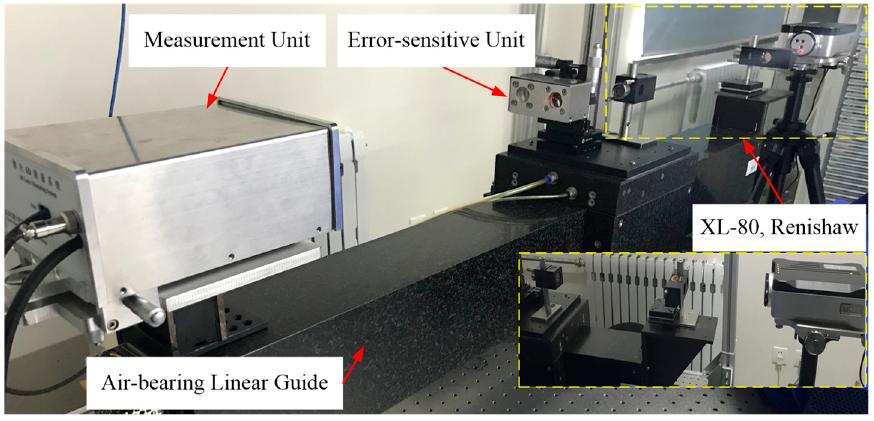
Figure 5. Measurement experiments for the linear axis.